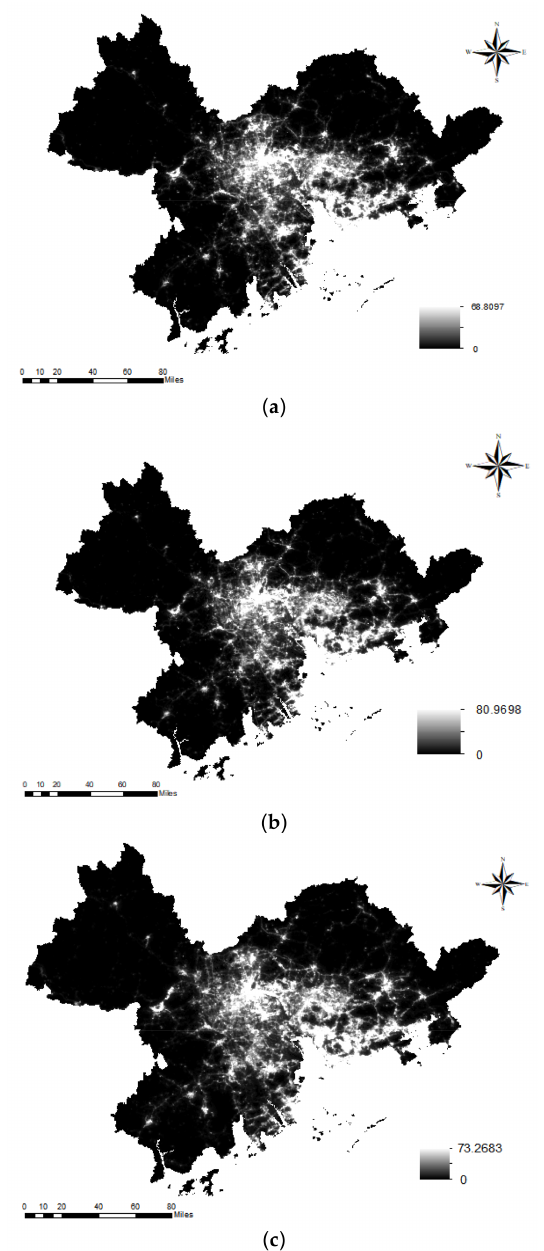
Figure 4. Denoised NTL remote sensing image in the PRD. ( a ) 2013, ( b ) 2016, ( c )